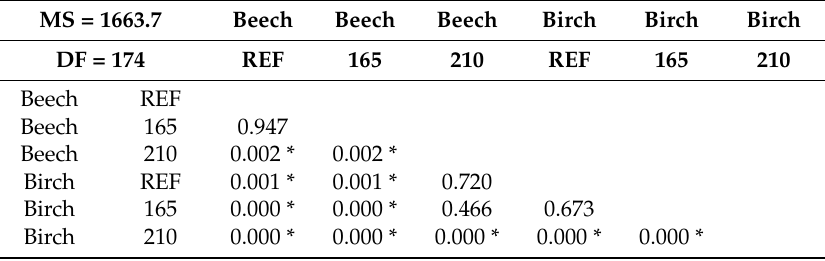
Table A1. Duncan’s Multiple Range Test for Wood Density.